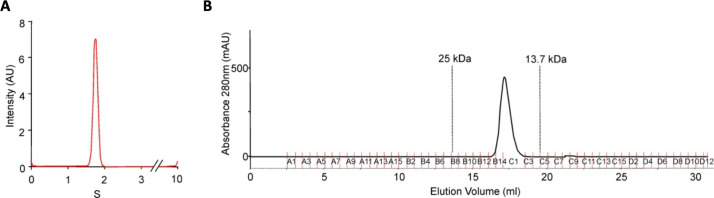
DolP is monomeric.(A) DolP, lacking the site of acylation, was purified and subject to analytical ultracentrifugation. DolP demonstrated a uniform sedimentation velocity consistent with a monomeric species. (B) Column chromatography of purified DolP revealed that it had an elution profile consistent with a single monomeric species.